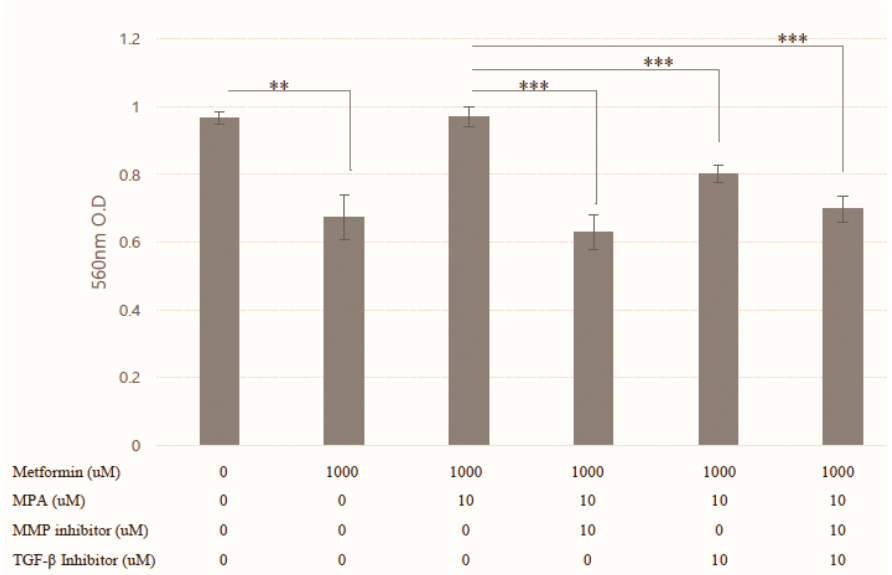
Figure 6. Cell invasion after combination treatment of 1mM metformin (Met), 10 µM medroxyprogesterone (MPA), 10 µM Matrix metallopeptidase (MMP) inhibitor and transforming growth factor (TGF)- β inhibitor in KLE cell lines. Each experiment was independently performed in triplicate: results are expressed as mean ± standard deviation. Multiple testing correction was performed using Bonferroni adjustment and Bonferroni corrected p -values were used for statistical significance. ** p < 0.005, *** p < 0.0005.